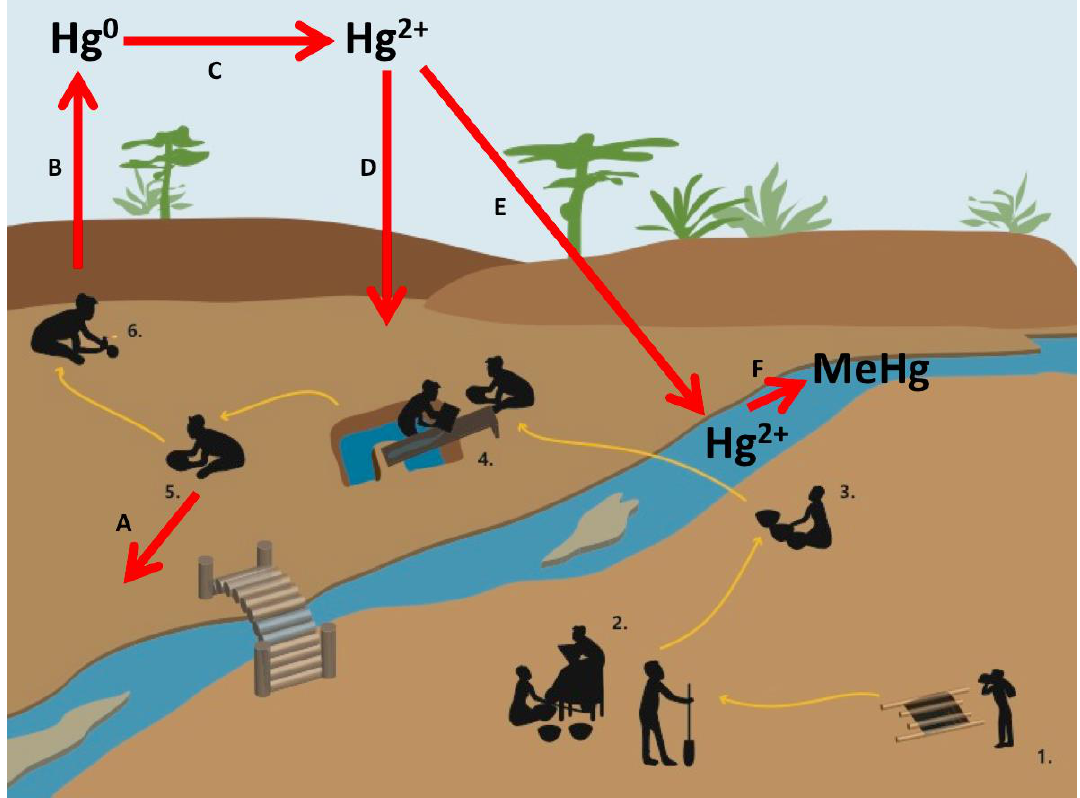
Figure 3. Mercury (Hg) cycle in a typical artisanal and small-scale gold mining (ASGM) process. Numbers represent key steps in the ASGM process: 1—excavation, 2—crushing and grinding, 3—sifting/shanking, 4—washing/sluicing, 5—amalgamation, and 6— burning. Letters represent key steps in the mercury cycle: A—residual mercury from amalgamation may be discarded in local soil and water, B—volatilization of elemental mercury into the atmosphere, C—oxidation of elemental mercury, D—deposition onto local terrestrial systems, E—deposition onto local aquatic systems, F—methylation of inorganic mercury to